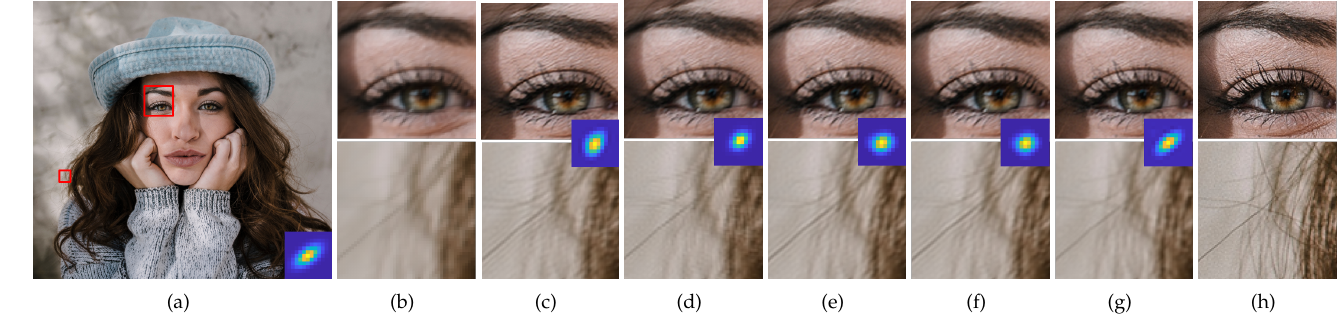
Figure 10. SR results of the 8th image degraded by the 12th kernel of DIV2KSK dataset using the estimated kernels for scale factor of × 2. The first row is the ZSSR results and the second row is the results of solving Equation (2). From ( c ) to ( g ), the estimated kernels are shown in the middle of each column. ( a ) GT image and kernel, ( b ) LR, ( c ) KernelGAN [20], ( d ) FKP [21], ( e ) E-KernelGAN [22], ( f ) E-KernelGAN-DIP [22], ( g ) TVG-KernelGAN, ( h )